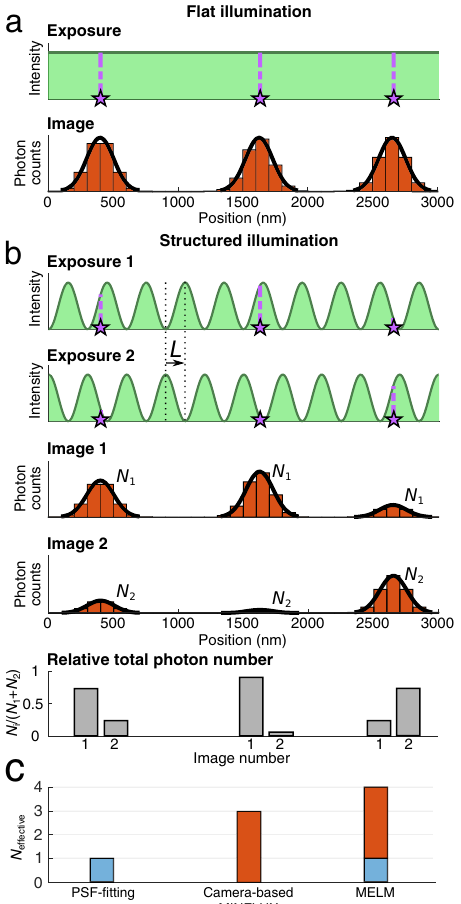
Fig. 1 Illustration of MELM and its theoretical performance. a In conventional camera-based localization microscopy, the illumination is spatially constant (green line). Thus, all fl uorescent point-source (purple stars) are illuminated with the same intensity. Consequently, the diffraction- limited images (spots) of identical sources (orange bars) are equally intense on average. If those spots are non-overlapping, the position of each point- source can be determined by fi tting its spot with a model point-spread function (PSF) (black solid lines, Methods). b Under structured illumination (Exposure 1, green line), the average number of photons, N 1 , in the diffraction- limited spot of each point-source (Image 1, orange bars) depends on the position of the source relative to the illumination. If the structured illumination is phase-shifted (Exposure 2, green line), the average number of photons, N 2 , in the diffraction-limited spot of each point-source changes (compare Image 1 to Image 2, orange bars). Regardless of intensity, the position of a point- source thus imaged twice is determined by fi tting a model-PSF that has the position coordinate among its fi tted parameters (black solid lines). Since we know the structure of the illumination from calibration and the distance, L , it was translated (Methods), the relative number of photons N 1,2 /( N 1 + N 2 ) in the two spots from a point-source reveal its position modulo L (Methods). c The resulting effective photon number of an optimized MELM method ( N effective in Eq. 1), is the sum of the effective photon numbers for PSF- fi tting and camera-based MINFLUX, assuming identical total exposure time (Methods, Supplementary Fig. 1). Note that the values for N effective correspond to the values realized in our 2D C-MELM experiment below (Supplementary Fig. 1, Supplementary Note 7 –